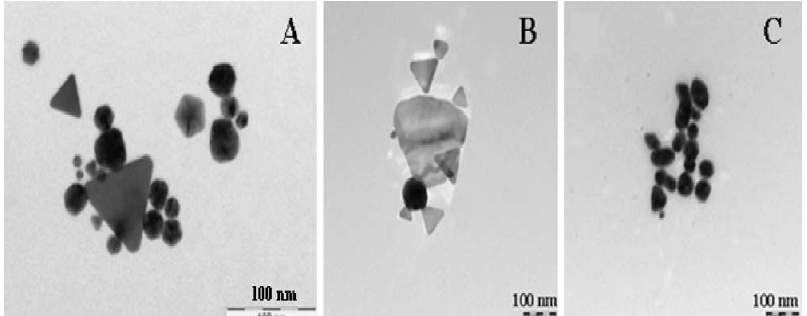
Fig. 6. TEM images of the gold nanoparticles formed by the reaction of 1 mM HAuCl4 and 5% Magnolia Kobus leaf broth at different reaction temperatures: (A) 25 o C, (B) 60 o C, and (C) 95 o C.